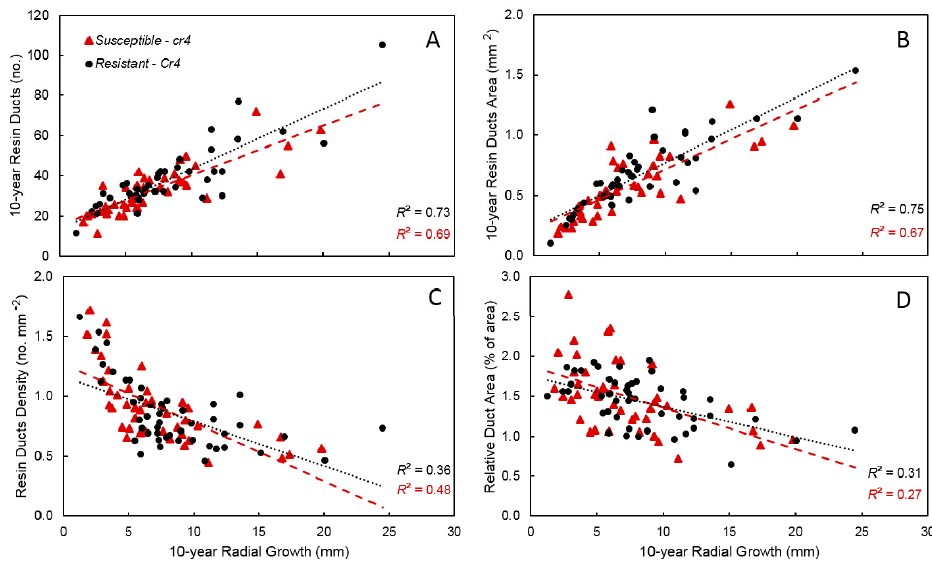
Figure 3. Limber pine vertical resin duct metrics for the 10-year interval from 2001 to 2010 as a function of the 10-year radial growth increment. Resin duct production ( A ) and resin duct area ( B ) were positively correlated with radial growth. Resin duct density ( C ) and relative duct area ( D ) significantly decreased with radial growth. All metrics were calculated using the extracted cores, not the entire tree stem. Black circles are trees inferred in previous studies to carry the dominant Cr4 allele for complete resistance to WPBR; red triangles are for trees that lack the dominant Cr4 allele. Regression lines are shown for those relationships that are significant ( p < 0.05); regression relationships for each metric did not differ between R and S trees.